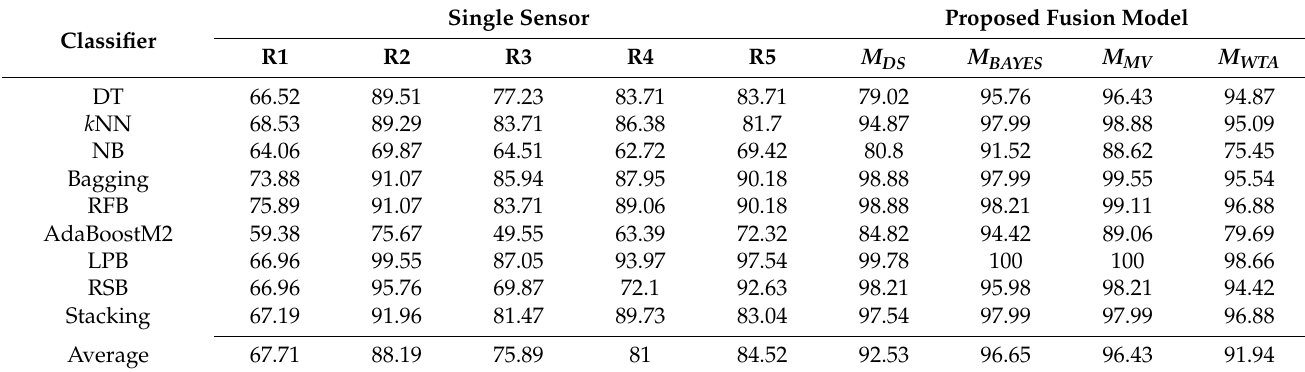
Table 4. Mean accuracy of independent sensor and fusion model with PCA (in %).